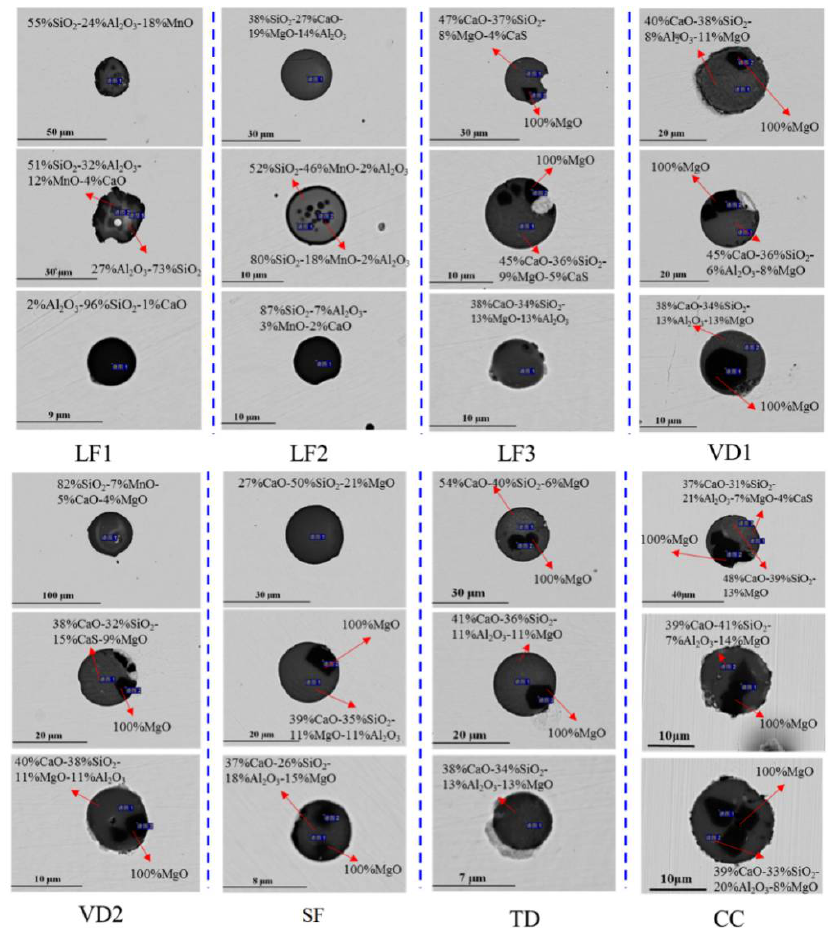
Figure 2. Morphology and composition of typical inclusions in steel.